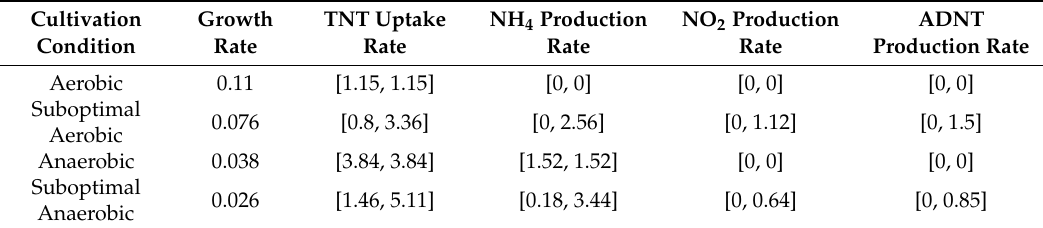
Table 2. Variability of TNT uptake rate (TNTUR) and flux through TNT degradation products under different cultivation